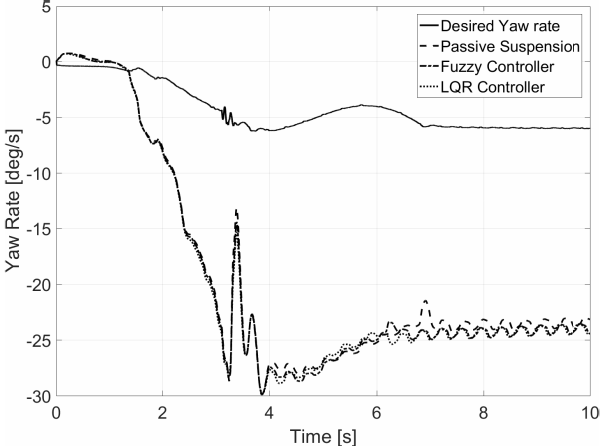
Figure 14. Yaw rate for Test 2.